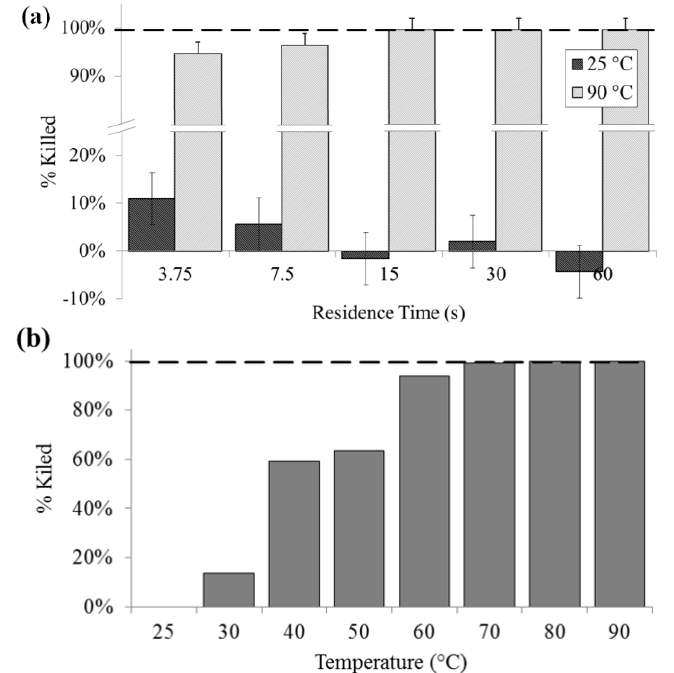
Figure 2. Lysis performance as indicated by a decrease in colony forming units compared with a bead-beaten positive control (– – –). ( a ) For a range of on-chip residence times from 15 to 60 s at room temperature (25 °C) and at maximum heat (90 °C). ( b ) For the full temperature range for 15 s residence time